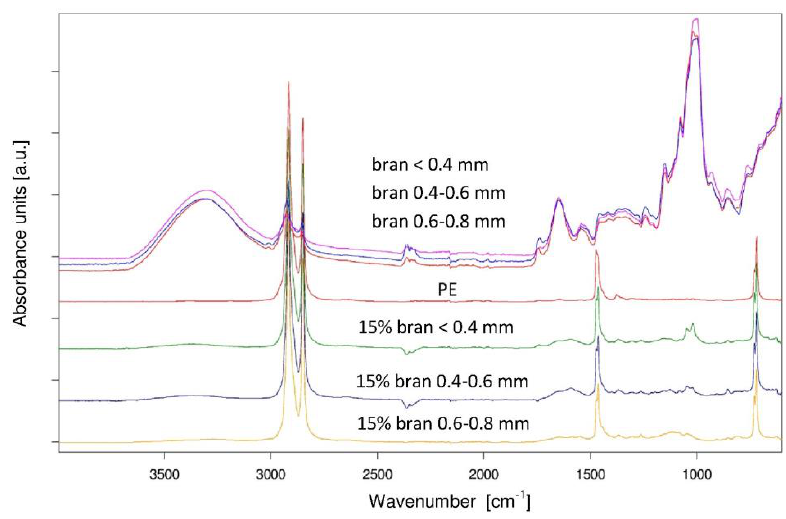
Figure 17. ATR-FTIR spectra of bran with di ff erent granulation, PE and PE pomace containing 15% by weight of bran.